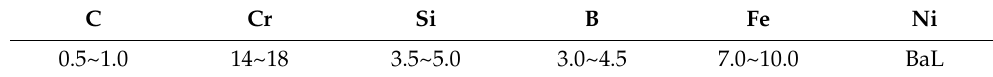
Table 2. Chemical composition of the Ni60 alloy (wt. %).